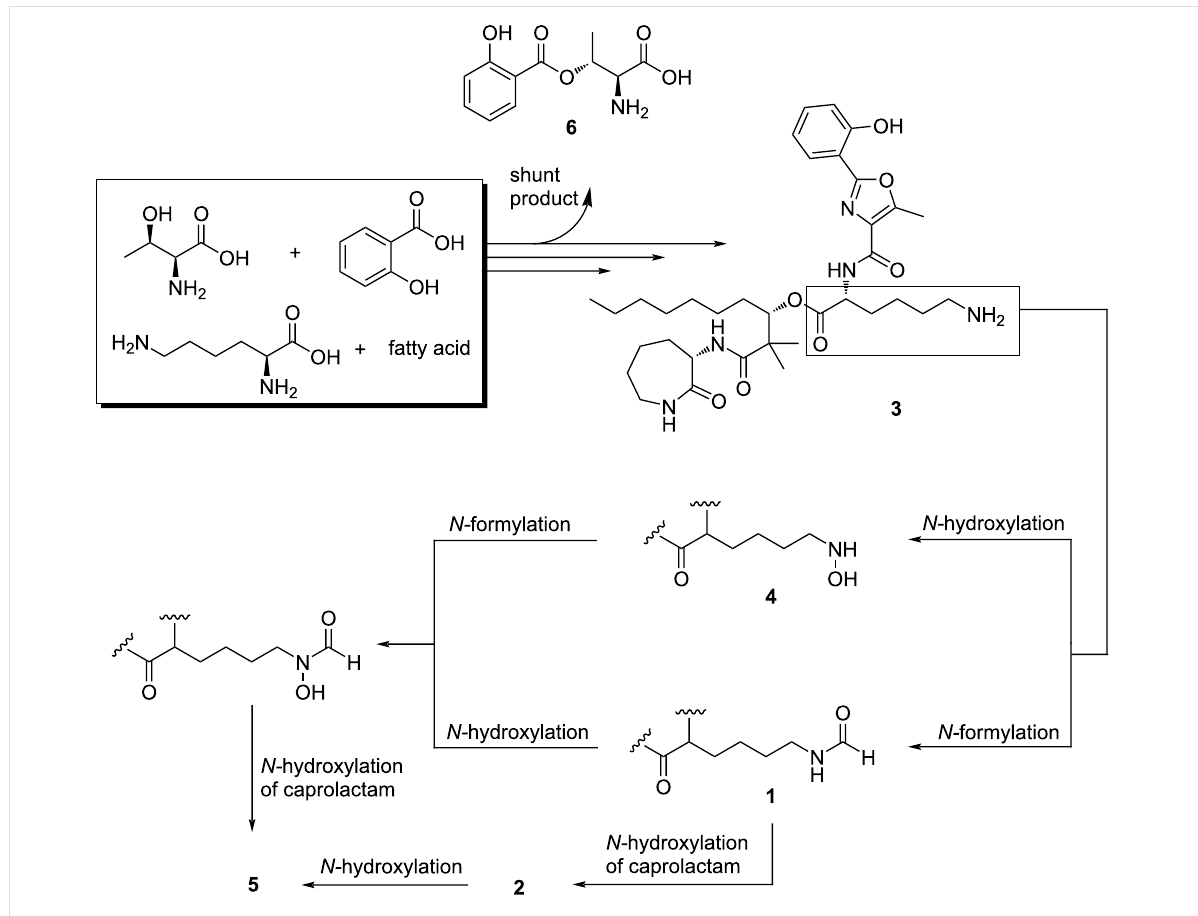
Figure 4: Proposed biosynthesis of amamistatins isolated in this